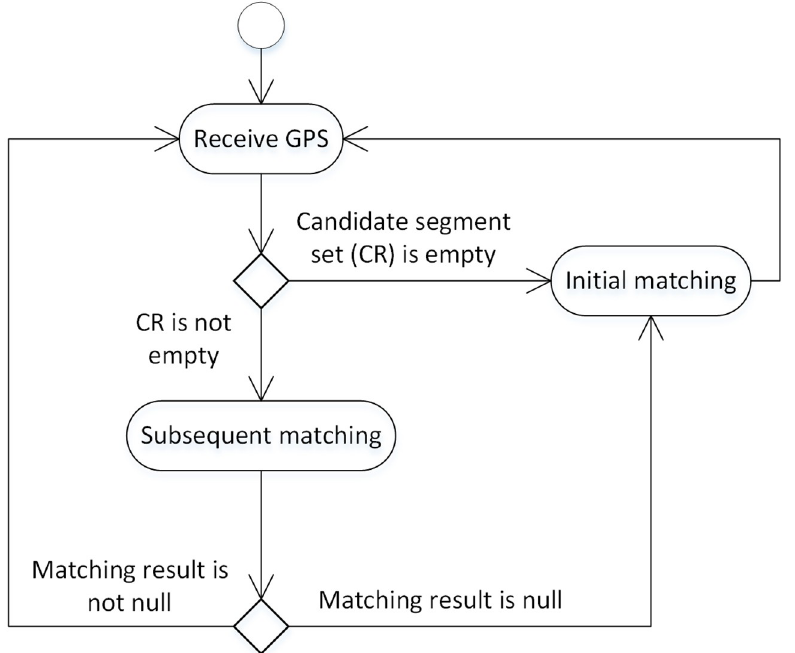
Fig 2. HMM-based matching algorithm without the junction decision